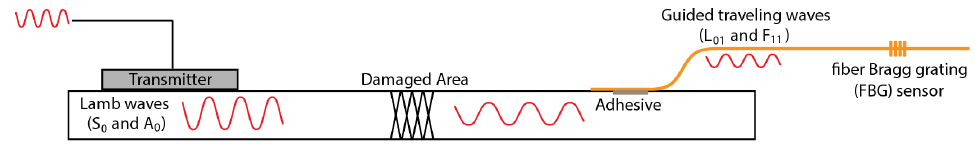
Figure 1. Remote bonding of a fiber Bragg grating sensor structure for guided wave inspection.